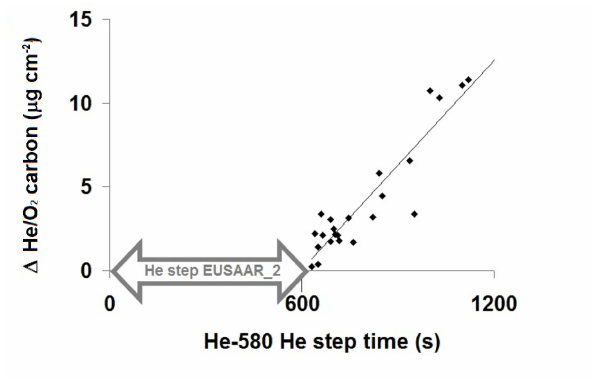
Fig. 8. Differences in He/O 2 carbon evolving applying EUSAAR 2 and He-580 protocols ( 1 He/O 2 carbon) as a function of the He step duration in the He-580